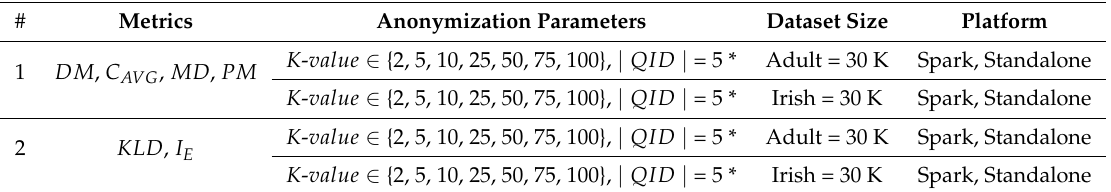
Table 5. Experimental Configurations for Data Privacy and Utility.